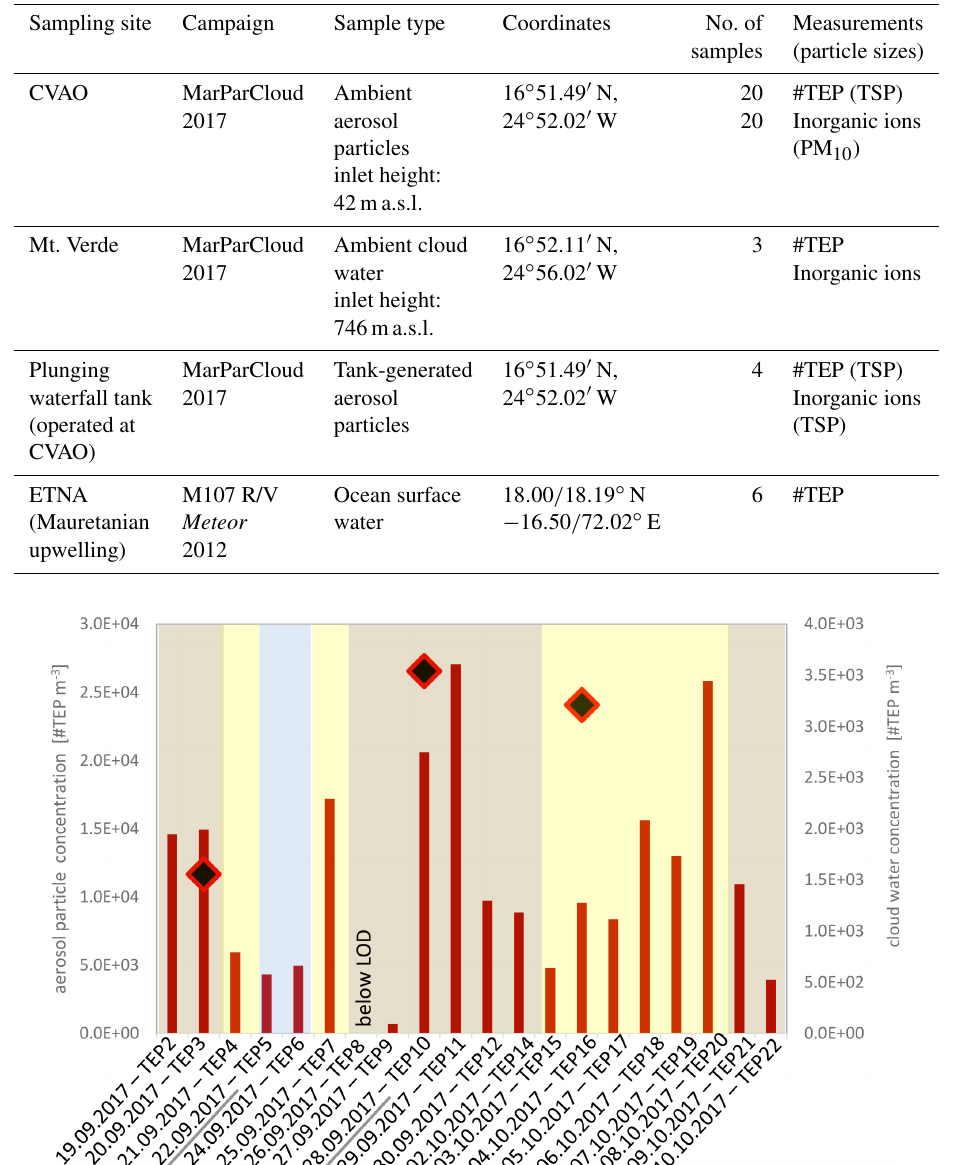
Table 1. Overview of sampling locations, types, and measurements.